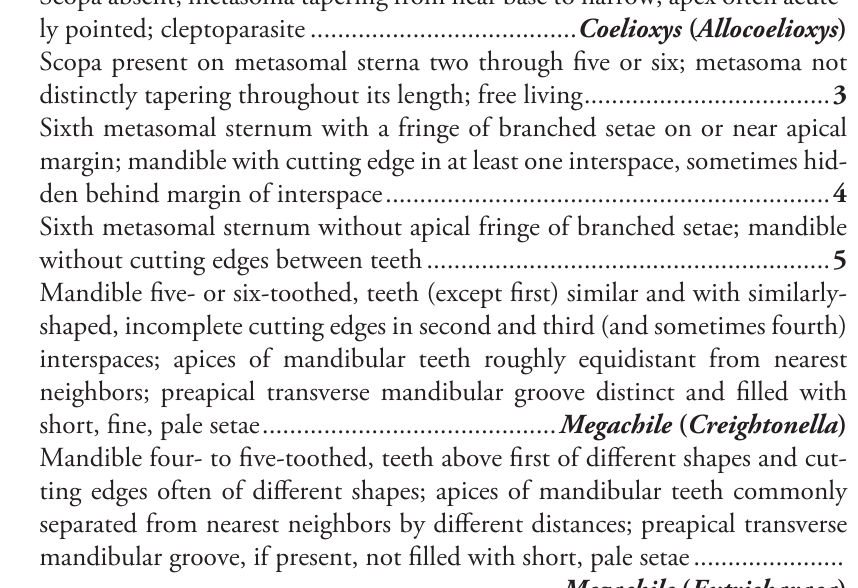
2(1) Scopa absent; metasoma tapering from near base to narrow, apex often acute- ly pointed; cleptoparasite ....................................... Coelioxys ( Allocoelioxys ) – Scopa present on metasomal sterna two through five or six; metasoma not distinctly tapering throughout its length; free living .................................... 3 3(2) Sixth metasomal sternum with a fringe of branched setae on or near apical margin; mandible with cutting edge in at least one interspace, sometimes hid- den behind margin of interspace ................................................................. 4 – Sixth metasomal sternum without apical fringe of branched setae; mandible without cutting edges between teeth ........................................................... 5 4(3) Mandible five- or six-toothed, teeth (except first) similar and with similarly- shaped, incomplete cutting edges in second and third (and sometimes fourth) interspaces; apices of mandibular teeth roughly equidistant from nearest neighbors; preapical transverse mandibular groove distinct and filled with short, fine, pale setae ........................................... Megachile ( Creightonella ) – Mandible four- to five-toothed, teeth above first of different shapes and cut- ting edges often of different shapes; apices of mandibular teeth commonly separated from nearest neighbors by different distances; preapical transverse mandibular groove, if present, not filled with short, pale setae ...................... ........................................................................... Megachile ( Eutricharaea ) 5(3) Distal margin of clypeus irregularly rounded (rarely weakly emarginate me- dially), usually strongly crenulate, produced well over base of labrum, not thickened; mandible usually slender with apical margin strongly oblique; head little developed posteriorly, ocelloccipital distance thus not greater than interocellar distance ....................................... Chalicodoma ( Chalicodoma ) – Distal margin of clypeus truncate, not crenulate, often not much produced over base of labrum, but if rounded and somewhat crenulate, then margin thickened and impunctate; head usually much developed posteriorly, ocelloccipital distance thus greater than interocellar distance ............ Chalicodoma ( Pseudomegachile ) 6(1) Sixth metasomal tergum with multispinose preapical carina, with two pairs of long, preapical spines, each spine of upper pair sometimes divided into two, or crenulate, rounded, or fused to other spine of pair; cleptoparasite ............. .............................................................................. Coelioxys ( Allocoelioxys ) – Sixth metasomal tergum with preapical carina not as above, often crenulate, medially emarginate, or sometimes reduced to two spines; free living ......... 7 7(6) Fifth and sometimes sixth metasomal sterna exposed and generally similar to preceding sterna (sometimes fifth sternum largely hidden but sixth sternum exposed); lateral extremity of carina of sixth tergum directed basad, away from apical margin of tergum ............................. Megachile ( Creightonella ) – Fifth and sixth metasomal sterna retracted, variously modified, less scle- rotized, less punctate, and less setose than first to fourth sterna; lateral ex- tremity of carina of sixth tergum absent or directed toward lateral extremity of apical margin of tergum ..........................................................................